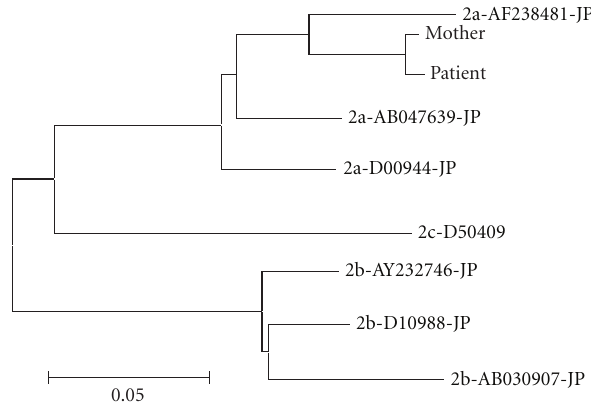
Figure 1: Phylogenetic analysis of hepatitis C virus in the patient and his mother. A phylogenetic tree was constructed using the neighbor-joining method. The horizontal axis shows the number of nucleotide substitutions per site. For example, 2a-AF238481-JP represents the strain of genotype 2a collected in Japan (registered no. AF238481 in GenBank).